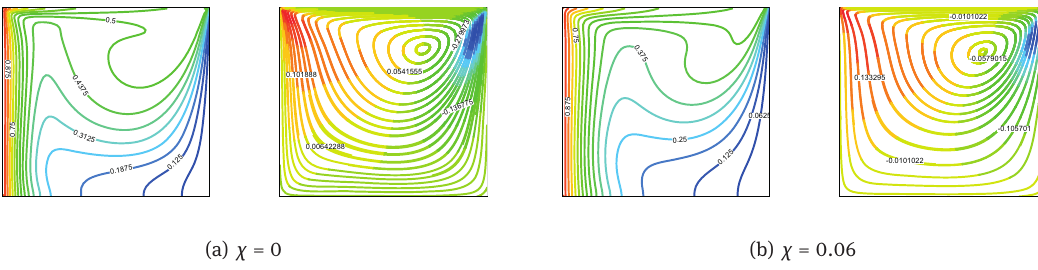
Fig. 5: Isotherms (left) and Streamlines (right) for different solid volume fraction with Ri = 1 , L H = 1, γ 2 = 3/6 , Da = 10 −2 , and ϵ = 0.4 .